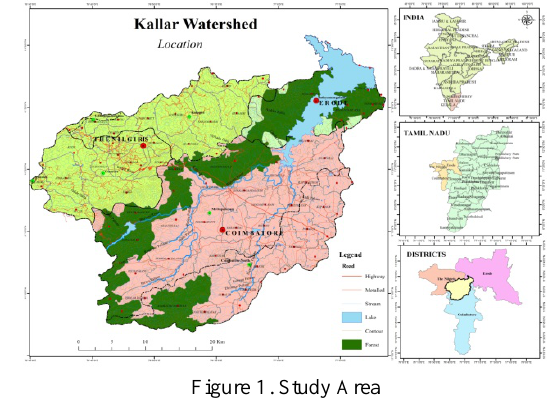
Figure 1. Study Area